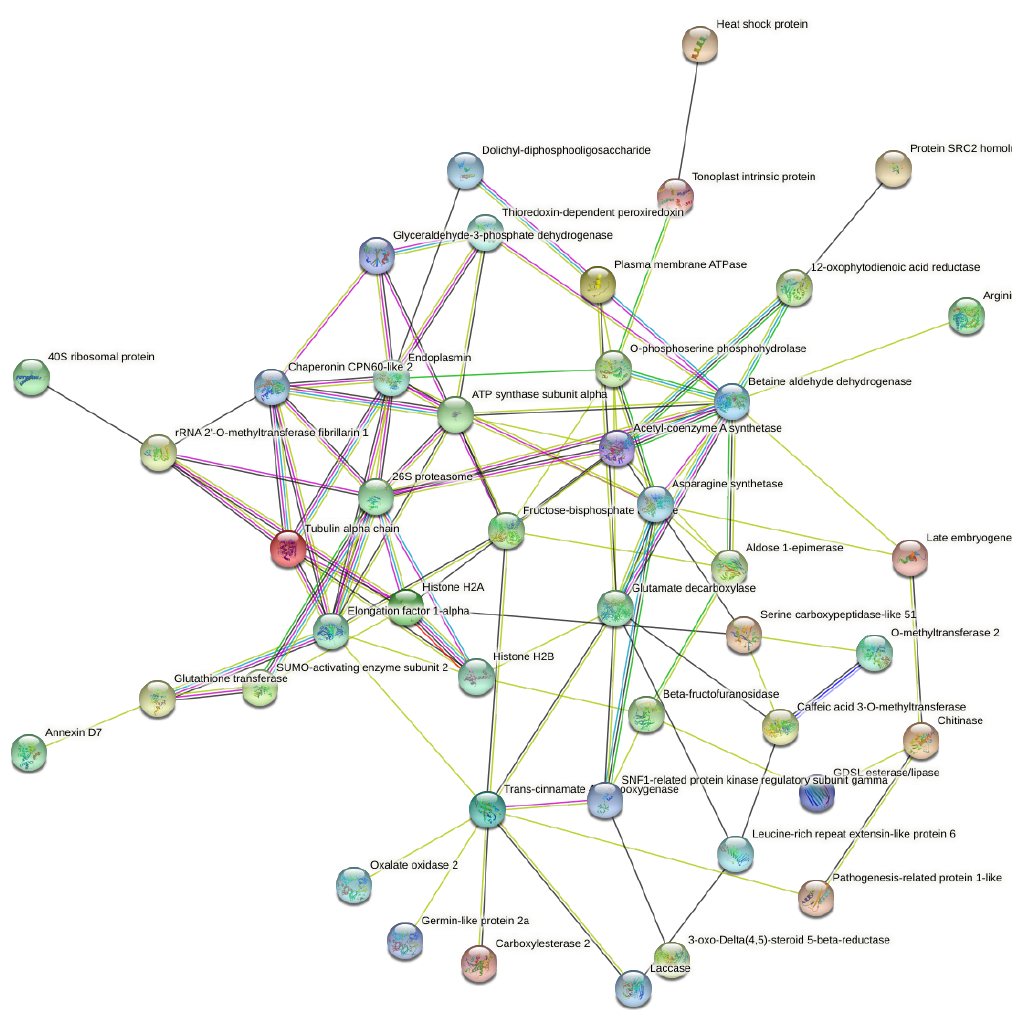
Figure 5. Analysis for protein-protein (PPI) interaction network for the DAPs. The different line colours represent the types of evidence used in predicting the associations: neighbourhood (green), co-occurrence across genomes (blue), co-expression (black), experimental (purple) and association in curated databases (light blue) or texting (yellow). Disconnected nodes or proteins not connected to the main network were hidden in the network.